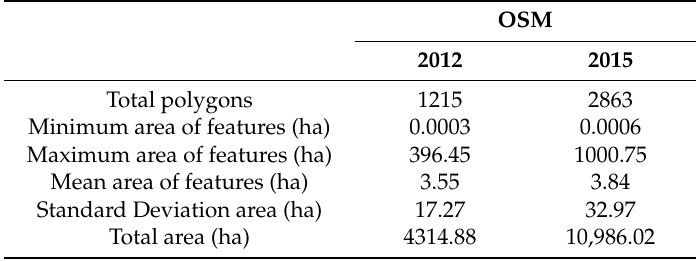
Table 4. Descriptive statistics for 2012 and 2015 OpenStreetMap (OSM)